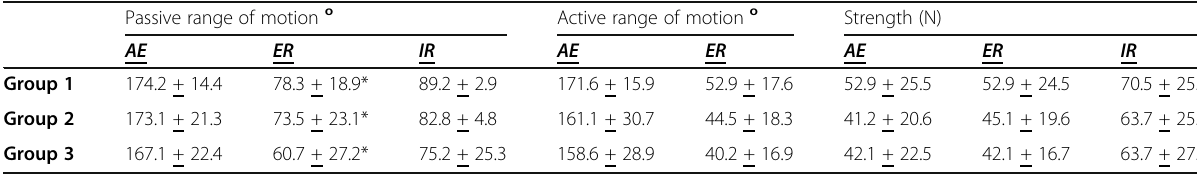
Table 4 Functional outcomes Passive range of motion